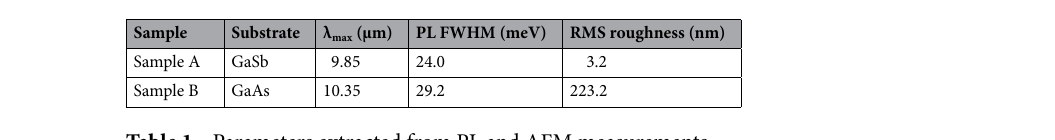
Table 1. Parameters extracted from PL and AFM